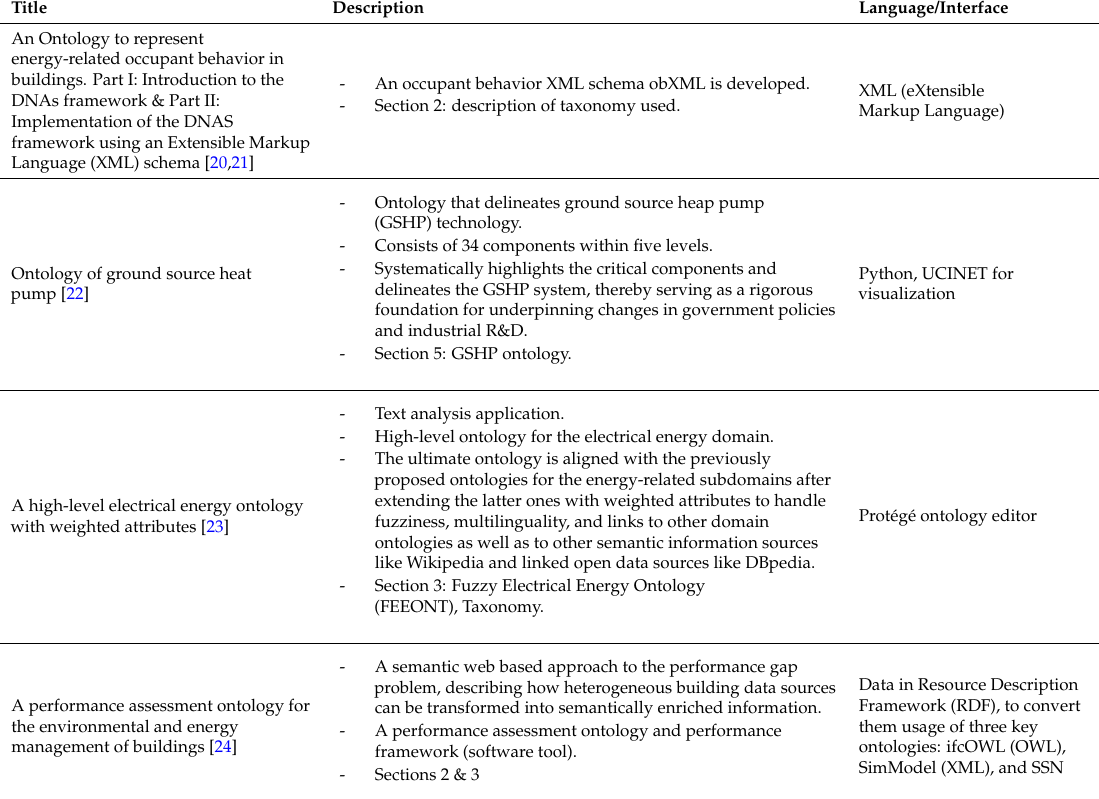
Table 1. Ontologies in various